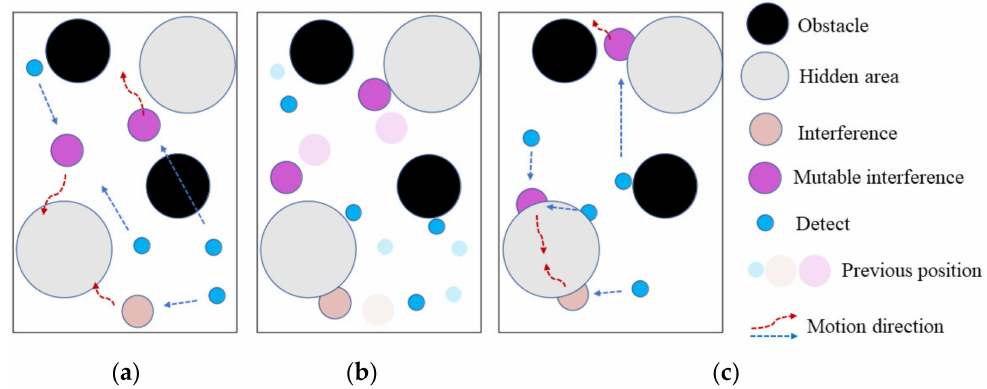
Figure 7. Tracking experiment before purple interference agents’ mutation (tracking experiment 1): ( a ) shows the motion trend of each agent, ( b ) shows the action of each agent, and ( c ) shows the results after each agent